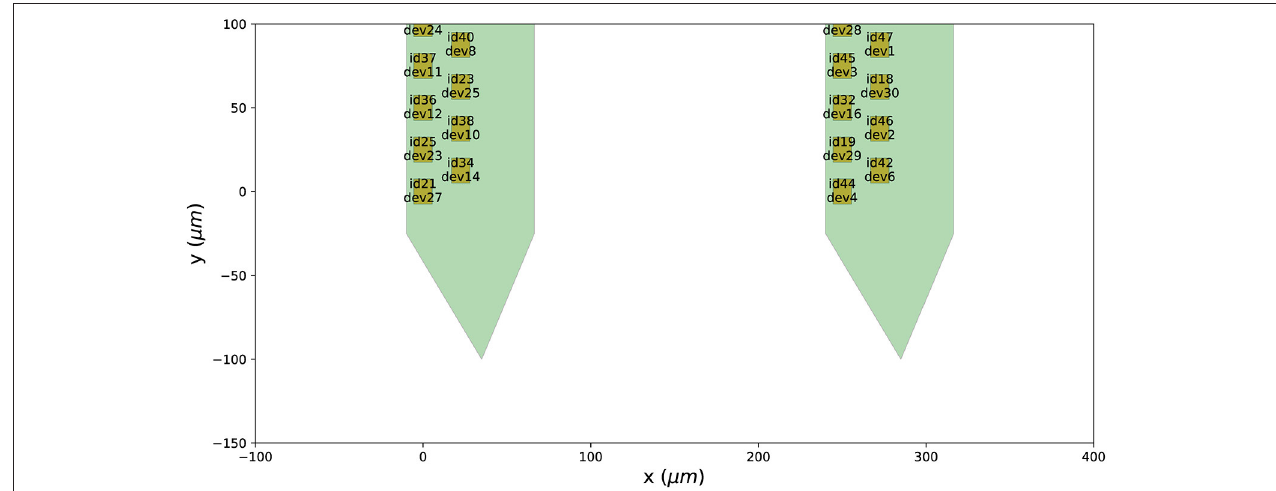
FIGURE 4 | Wiring a probe to an acquisition device. When a probe is wired to a device, each contact is assigned a device_channel_index , which indicates to which recorded trace it corresponds to. For each contact, the text shows both the contact id (e.g., id21 ) and the device channel index (e.g., dev27